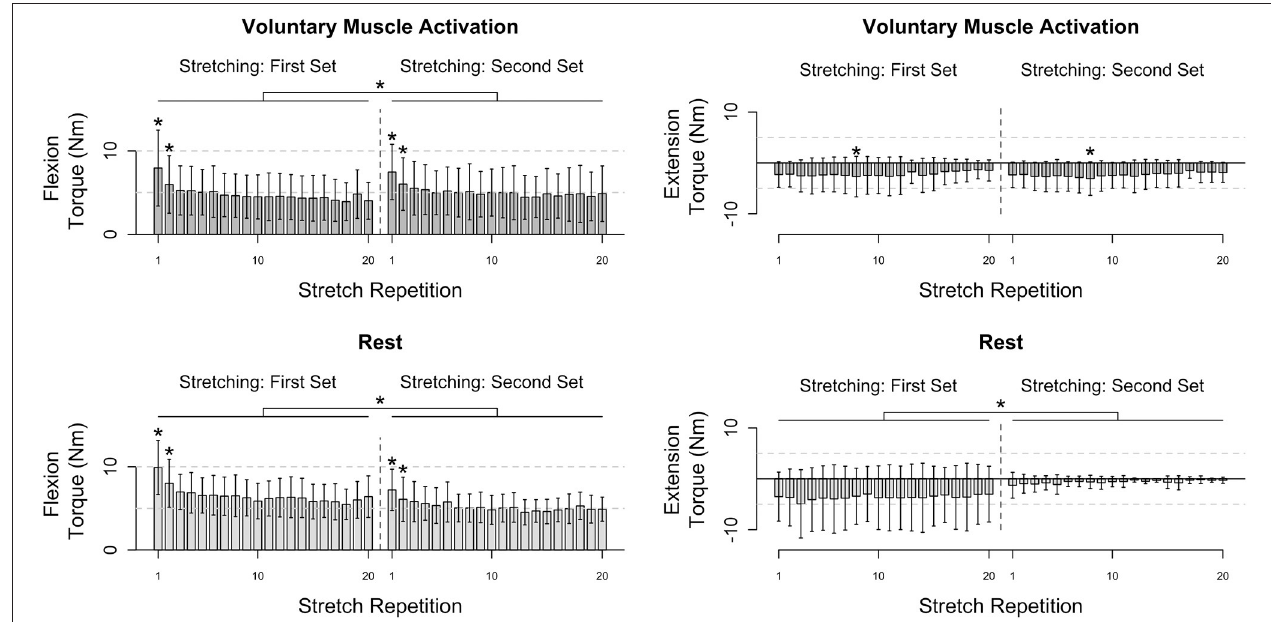
FIGURE 3 | Participants’ flexion and extension torque as a function of stretch repetition prior to and following voluntary muscle activation and rest. Mean (bar height) and lower and upper 95th percentile confidence intervals (error bars) are identified. A line with a star above indicates a significant difference between sets. An individual star indicates stretch repetitions that significantly differ from subsequent stretch repetition(s). Post-hoc comparisons for each significant stretch repetition are provided in Figure 4 .